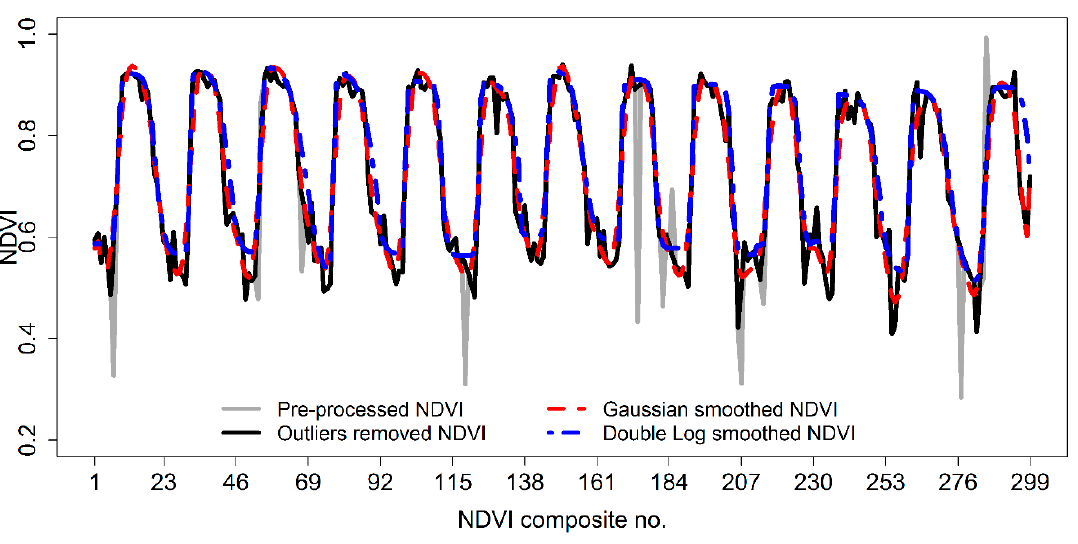
Figure 2. Illustration of smoothing of a pre-processed and outlier removed NDVI time series using Gaussian and Double Log functions. Note: In comparison to the Double Log smoothed NDVI, the Gaussian smoothed NDVI shows lower residuals in the winter troughs. The residuals in the non-winter period are almost similar for both the smoothing techniques.